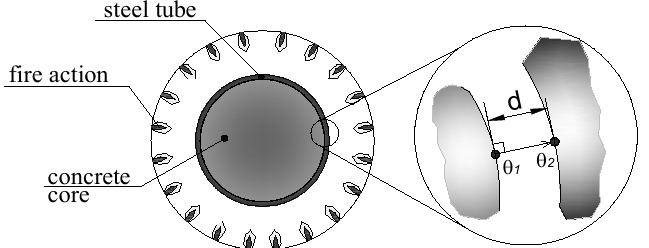
Figure 6. Gap between the two